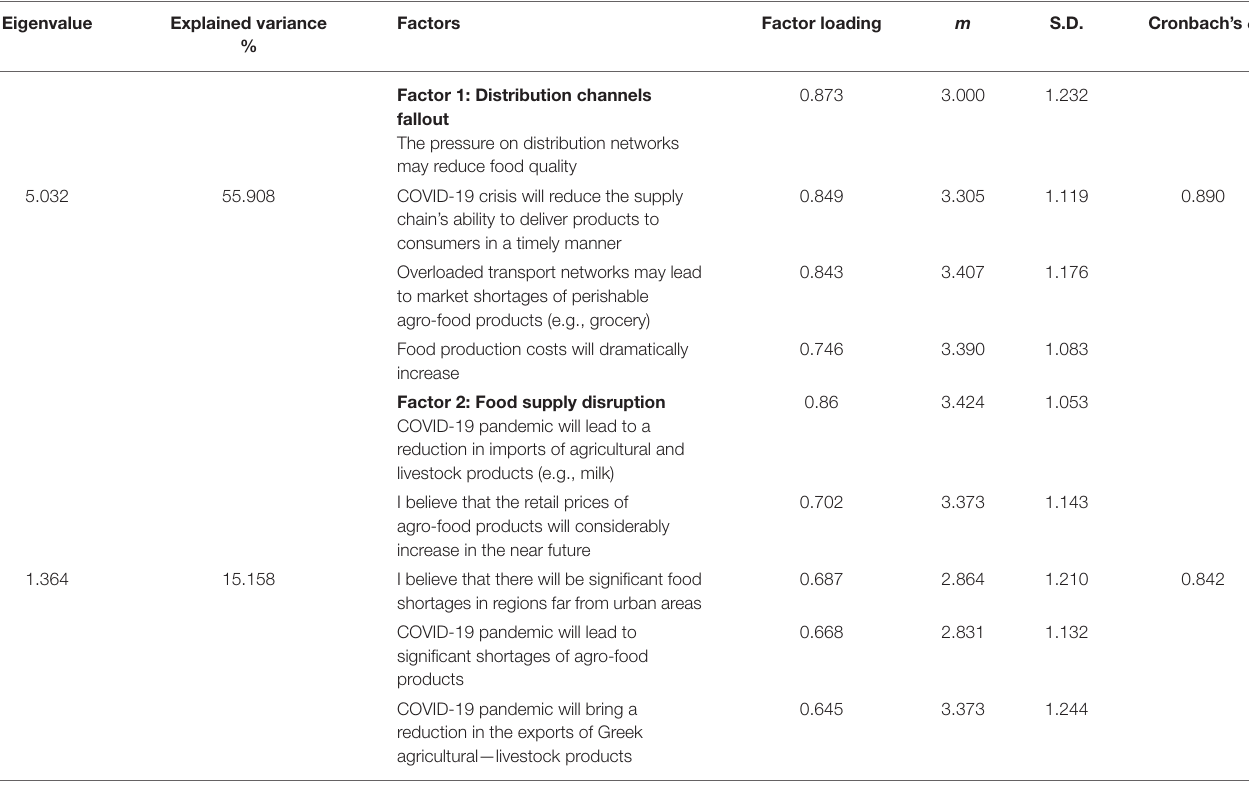
TABLE 7 | Factor analysis (PCA) and reliability analysis output on experts’ perceptions toward the impact of COVID-19 crisis on food distribution networks.